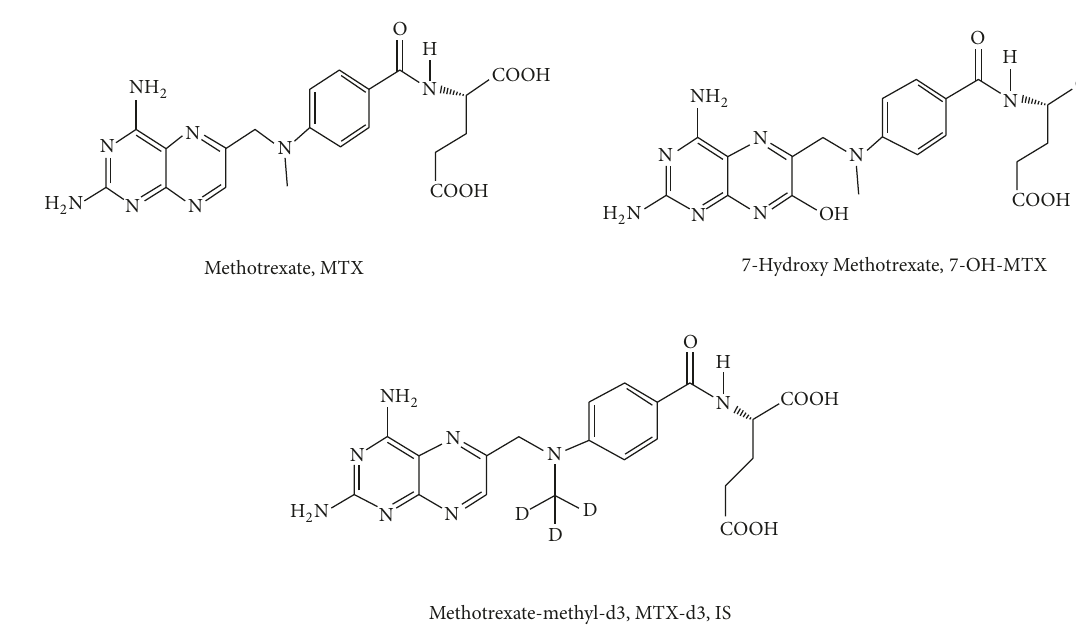
Figure 1: The chemical structures of MTX, 7-OH-MTX, and MTX-d 3